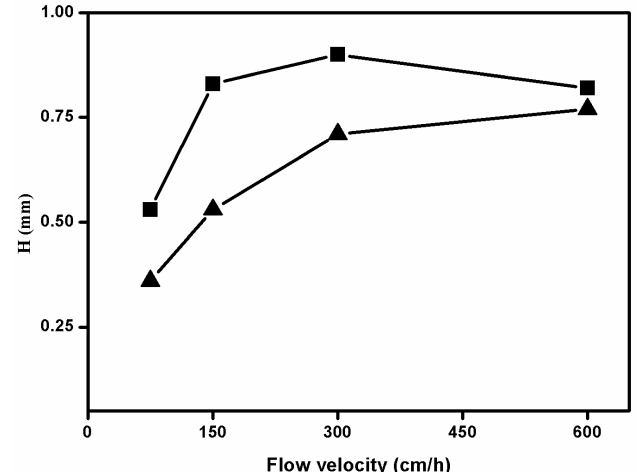
Figure 3. Theoretical plate height (H) versus flow velocity. Mobile phase: 20 mM phosphate buffer (pH 7.4). (■) Q fibrous adsorbent; (▲) Q Sepharose FF beads. Conditions: column, 5 mm ID × 5.5 cm L; sample: acetone 5% ( v / v ) of 1% column